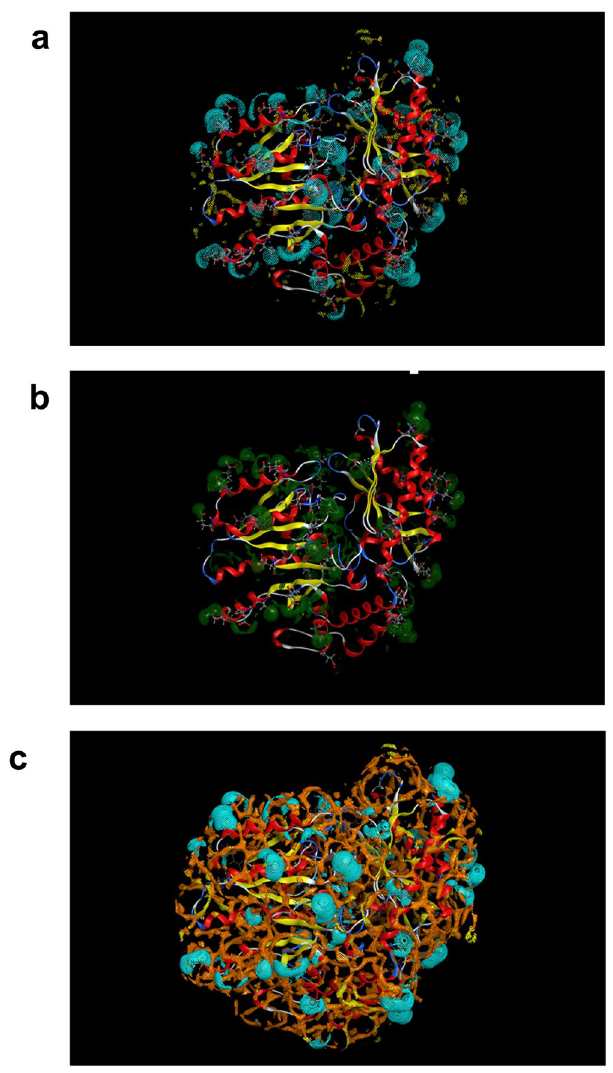
Figure 6. In silico solvent analysis of the Vb TA T16F surface ( a ) shows the hydration free energy iso-level density (solid green) with a DG cutoff value − 5.0 kcal/mol/A3; ( b ) shows the relative sodium and chloride ion iso-levels density relative to an 1 M bulk concentration of NaCl; ( c ) shows both the relative sodium and chloride ion iso-levels density relative to an 1 M bulk concentration of NaCl and the relative hydrophobe (a Lennard-Jones particle, i.e. a probe of the size of a neutral Cl atom) iso-levels density relative to a 50 mM bulk